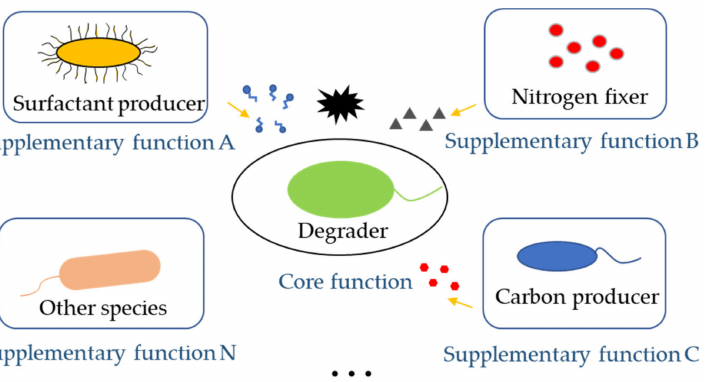
Figure 3. Multifunctionality in a microbial consortium. Degradation of pollutants is a core function of a synthetic microbial consortium. Supplementary functions, such as producing surfactant, nitrogen, or carbon resources, help the degraders to achieve the core